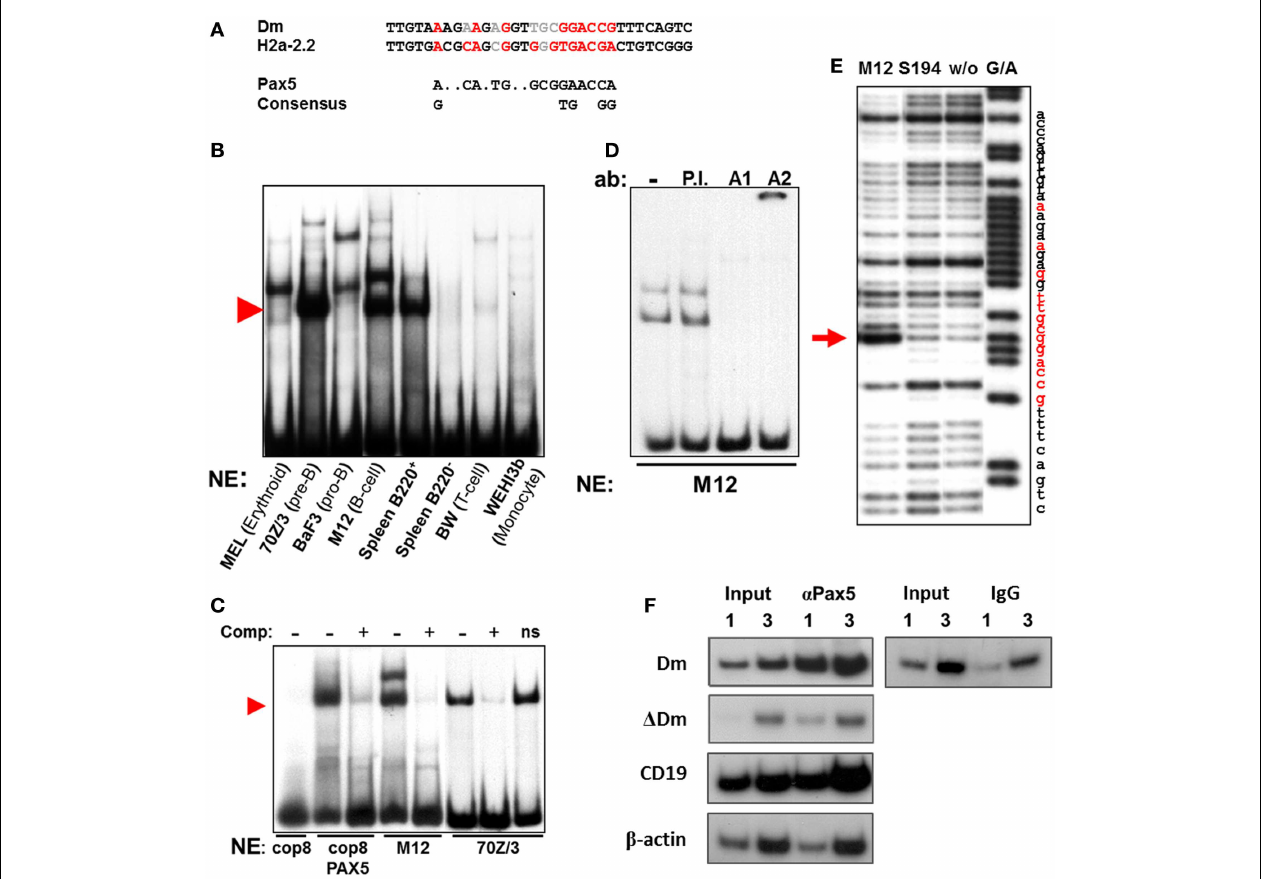
or general rabbit antisera (P.I.). (E) DNase I footprinting assay on end-labeled Taq I– Sac II probe from the Dm element. Labeled probe was incubated with nuclear extracts from the indicated cell types. A control Maxam and Gilbert reaction (G/A) was run in parallel. Footprint specific to Pax5-expressing M12 cells is indicated with a red arrow. Location of the putative Pax5-binding site is marked in red on the nucleotide sequence. (F) Chromatin immunoprecipitation (ChIP) enrichment of Pax5 at the Dm element in Ig κ wt/ ∆ Dm cultured pre-B cells. Enrichment was measured by semi-quantitative PCR via comparison of the input DNA (Input) to the immunoprecipitated fraction ( α Pax5), using primers specific to the Dm element (Dm) and the deleted allele ( ∆ Dm). One and three times the amount of PCR template were run in parallel to ensure linearity.